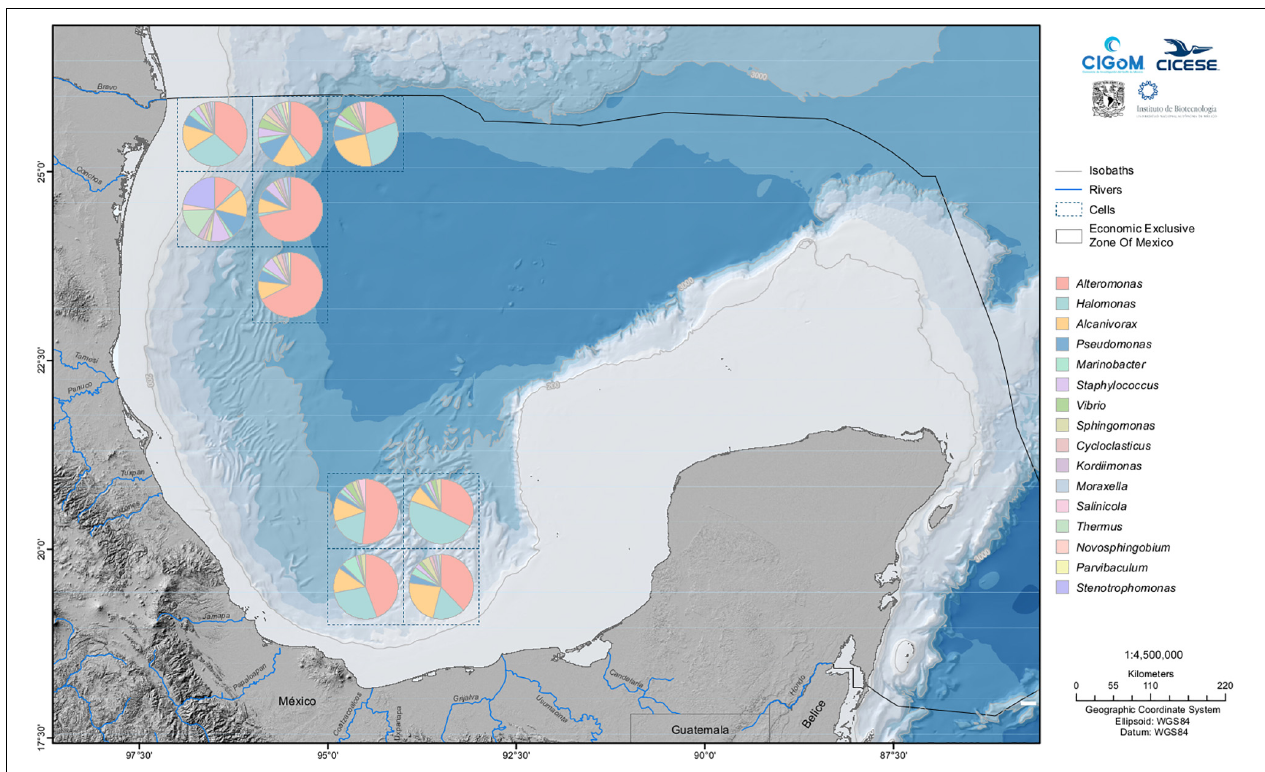
FIGURE 7 | Most abundant genera of hydrocarbon-degrading bacteria in the water column of the Gulf of Mexico. The genera appear in the legend according to their relative